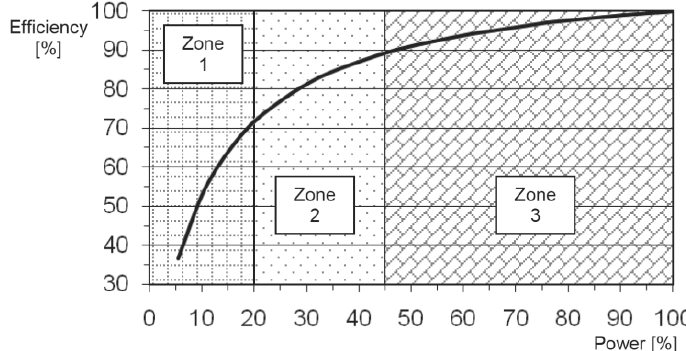
Figure 9. Engine e ffi ciency-power output curve. Figure 9. Engine efficiency-power output curve.